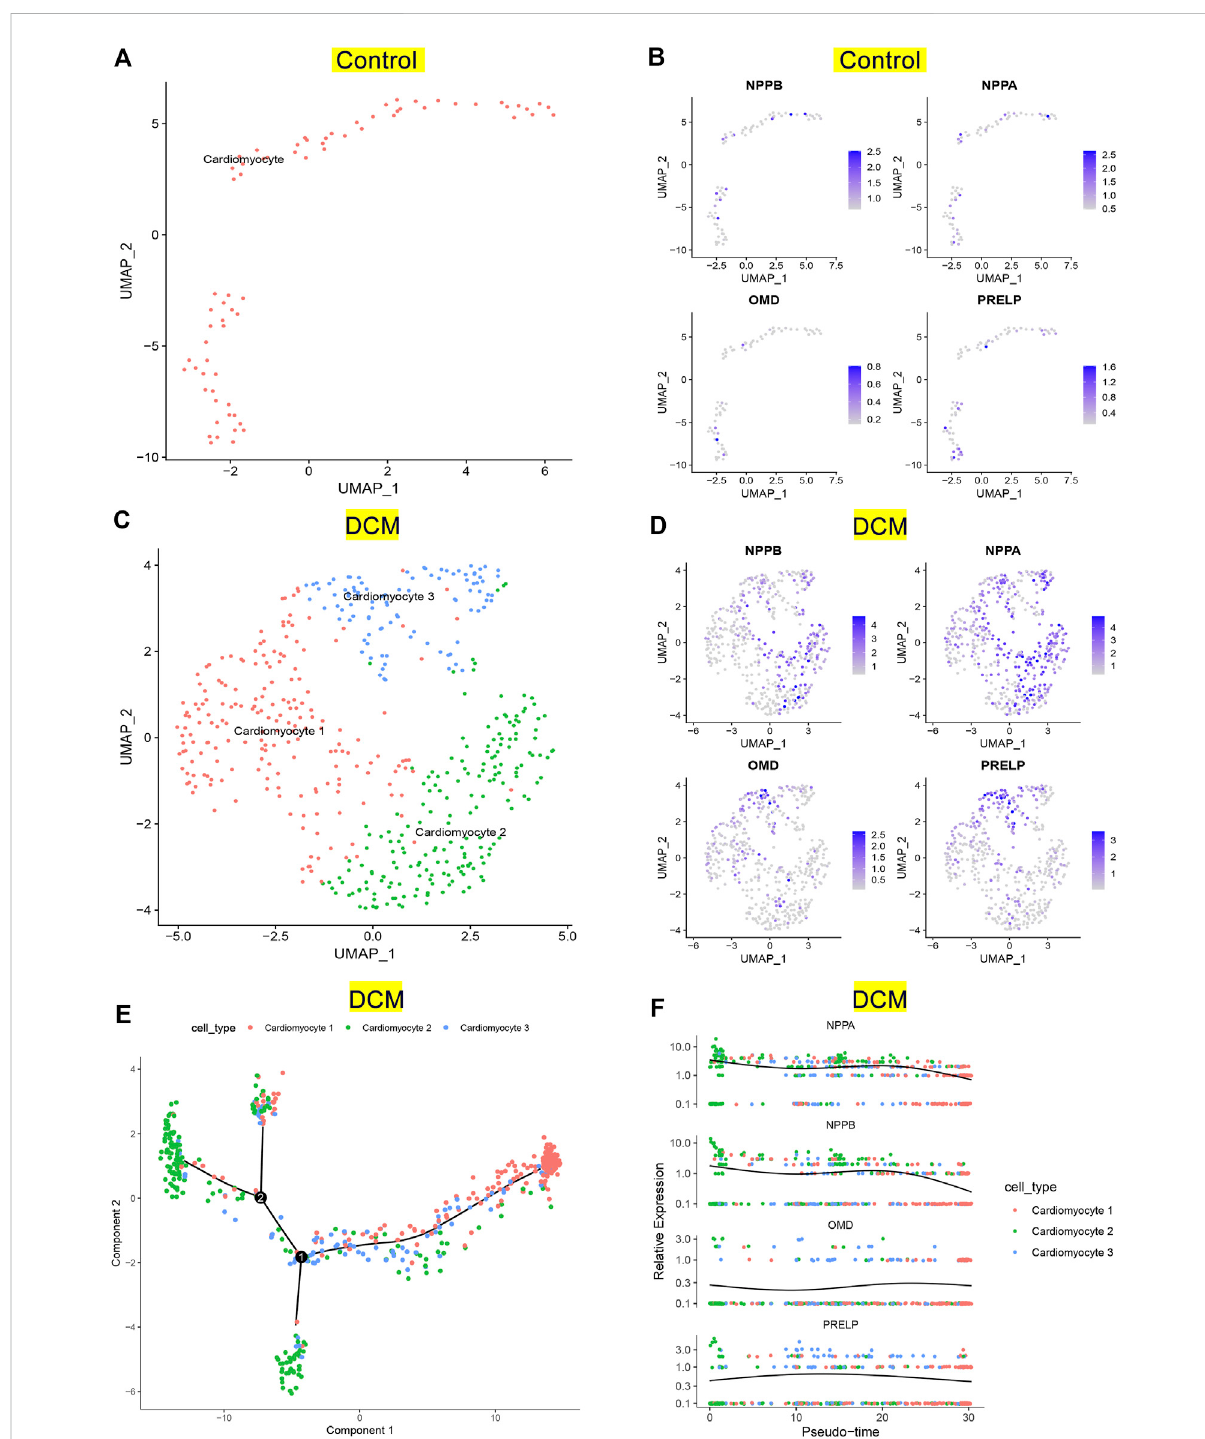
FIGURE 8 Veri fi cation of key genes expression pattern on single-cell RNA-seq analysis. (A) UMAP projection of distinct normal cardiomyocytes in GSE95140. (B) Distribution of NPPB, NPPA, OMD, and PRELP in distinct normal cardiomyocytes. (C) UMAP projection showing three types of cardiomyocytesofDCMpatientsinGSE95140. (D) DistributionofNPPB,NPPA,OMD,andPRELPindistinctcardiomyocytesofDCM. (E) Pseudotime- ordered analysis of cardiomyocytes of DCM. (F) Dynamic expression of NPPB, NPPA, OMD, and PRELP by the